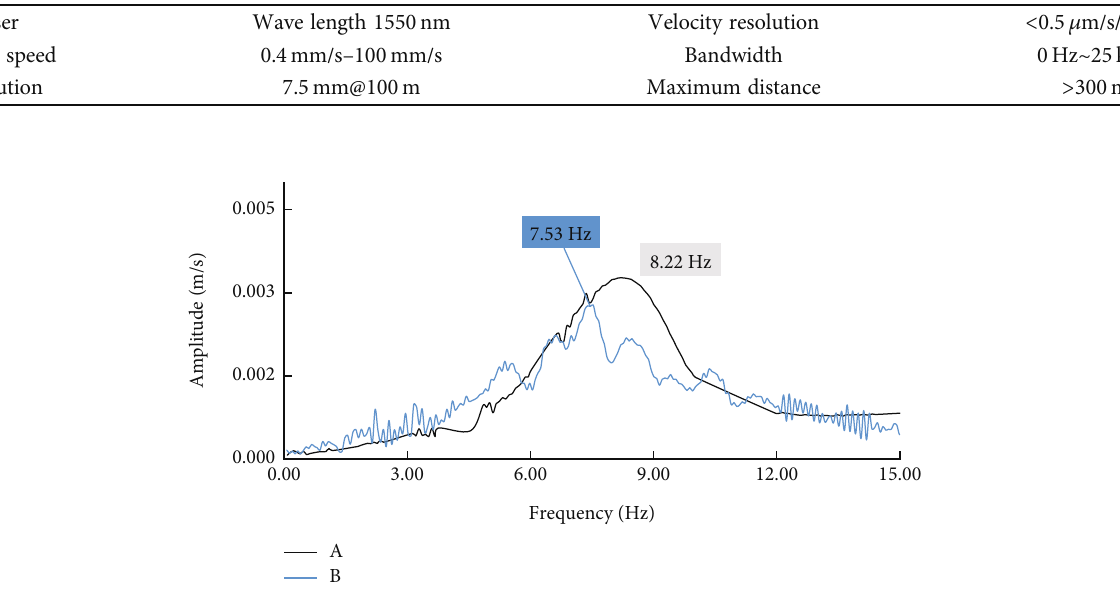
Figure 6: Results of the fi rst